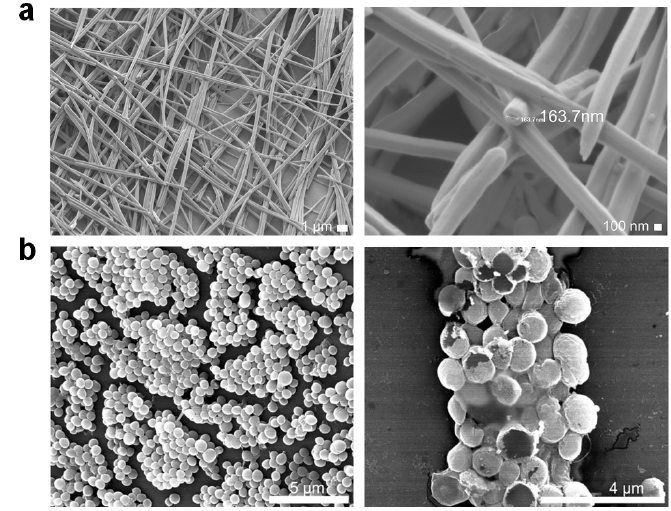
Figure 8. SEM of NH 2 -FF-COOH ( a ) nanotube self-assembly and ( b ) S. aureus treated with 2.5 mg/mL peptide. Adapted from [119] with permission from Elsevier. peptide. Adapted from [119] with permission from